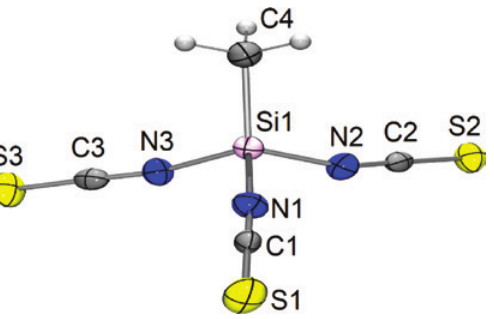
Figure 1: ORTEP view of the asymmetric unit of the starting material 13 in crystal form.